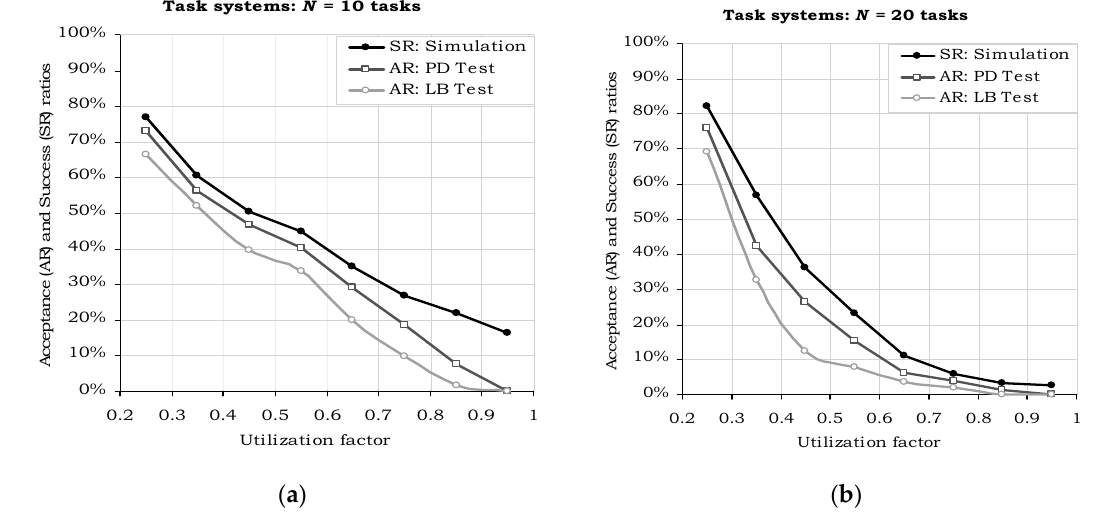
Figure 5. Acceptance ratios (AR) and success ratios (SR) versus total utilization factor. ( a ) N = 10 tasks, ( b ) N = 20 tasks.